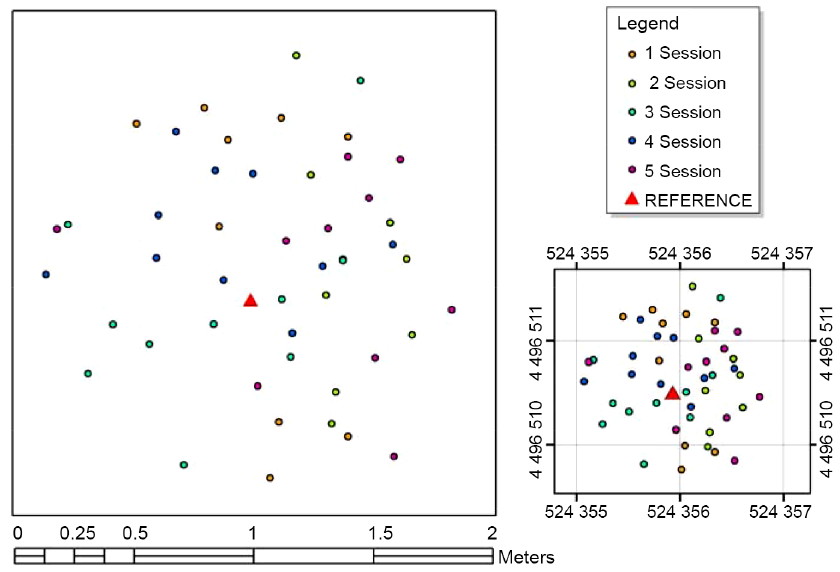
Figure 3. Spatial distribution of the points in different sessions on test site 1